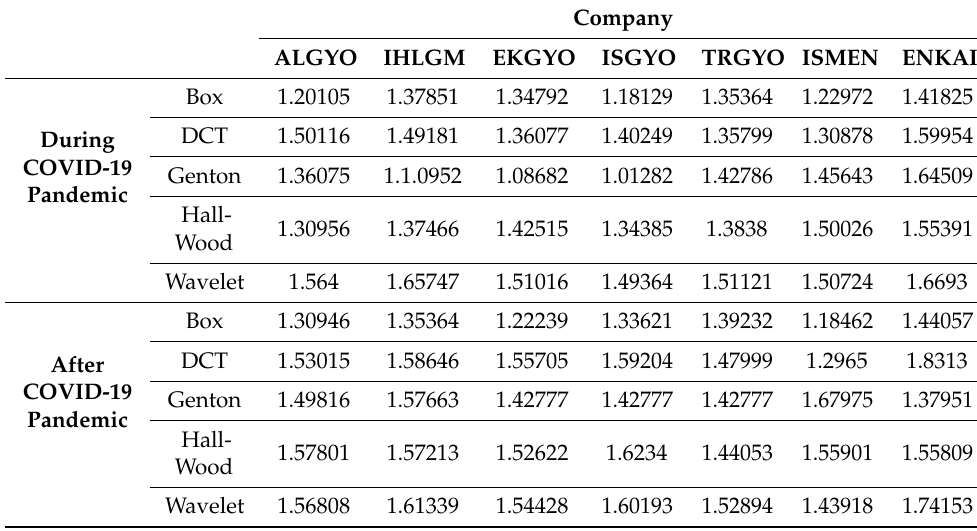
Table A3. Fractal dimensions for the real estate sector.